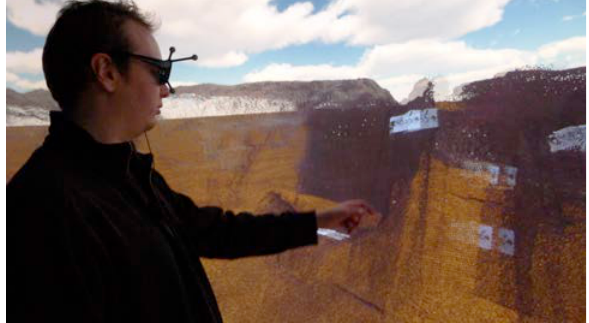
Figure 15. Immersive 1:1 view of the point cloud